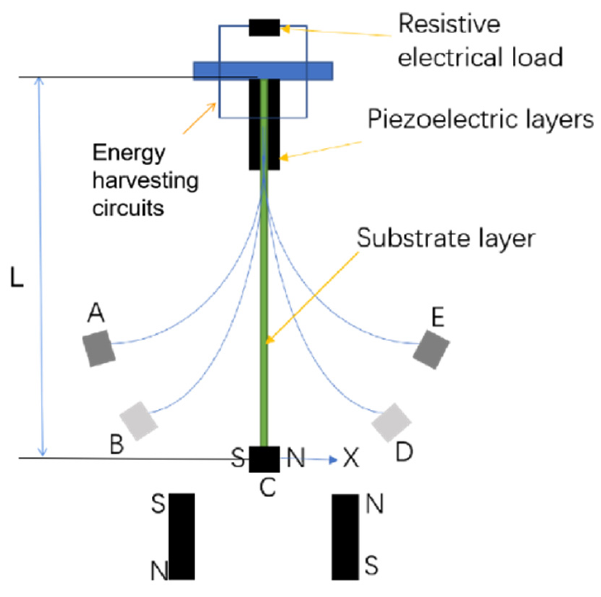
Figure 1. Simplified diagram of a tristable piezoelectric cantilever energy harvester.